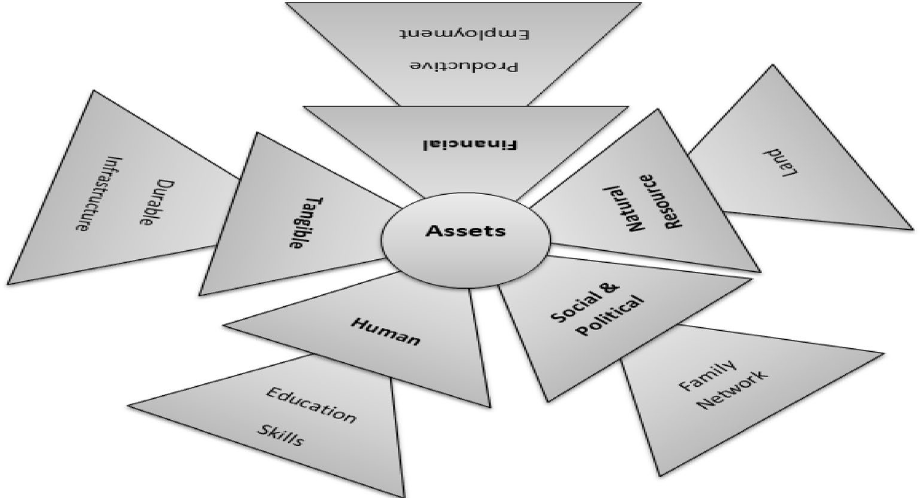
Fig. 1 Categories of